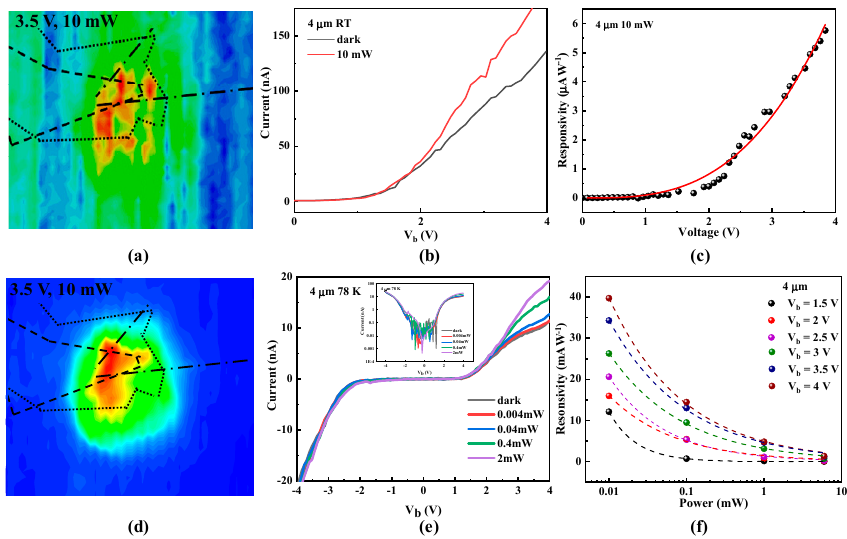
Figure 5. ( a ) Photocurrent mapping of the black phosphorus (BP) / boron nitride (h-BN) / graphene heterojunction device at room temperature with a 10 mW average illumination power and 3.5 V voltage. ( b , c ) are the current–voltage characteristic and photoresponsivity of the heterojunction device at room temperature. ( c ) Photocurrent mapping of the BP / h-BN / graphene heterojunction device at 78 K with a 10 mW average illumination power and 3.5 V voltage. ( e , f ) are the photocurrent and photoresponsivity in the BP / h-BN / graphene heterojunction device. Source-drain current as a function of source-drain voltage with a 4 µ m excitation wavelength with di ff erent incident powers detected at 78 K. The inset is a Logarithmic current-bias plot. The data in ( f ) is fitted to a power law I~P γ . The dashed lines show fitting results corresponding to each set of